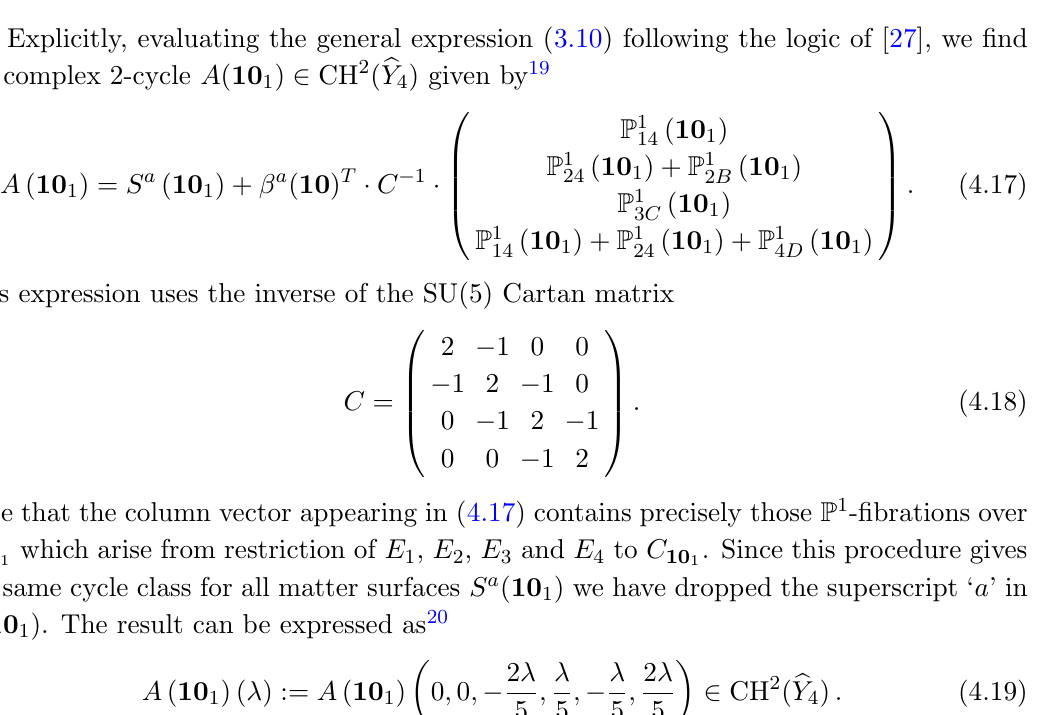
Table 2. Intersection points and intersection multiplicites (up to linear equivalence) of the matter curves C 10 , C 5 and C 5 in W 1 3 (cid:0) 2